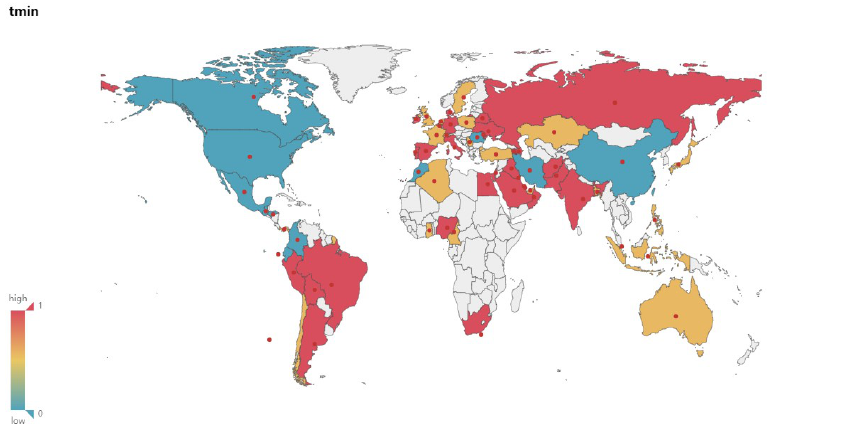
Figure 4. Correlation between New and Tmin.